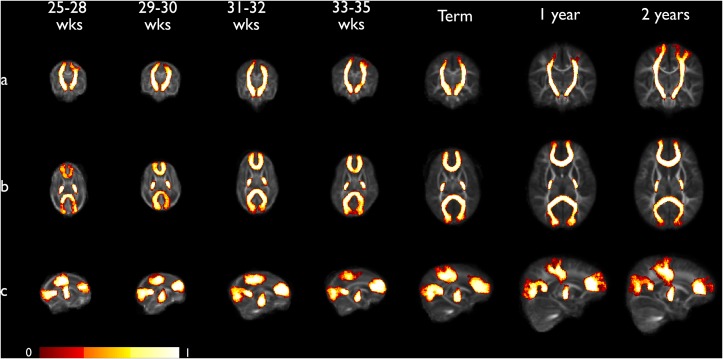
Coronal (a), axial (b) and sagittal (c) views of population-averaged tract probability maps for each developmental time point overlaid on mean FA atlas.Corticospinal tracts (CST), forceps minor and major are shown, thresholded at the 0.25 probability level. The intensity of each voxel represents the proportion of tracts that pass through that voxel across the whole group. This ranges from 0 probability (tract present at this voxel in none of the subjects) to 1 (tract present at this voxel in all subjects). The maximum spatial variation across the group is represented, however information is retained on the distributions that are most conserved across the population.